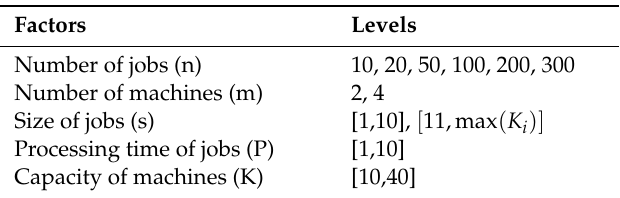
Table 4. Factors setting of the experiment.